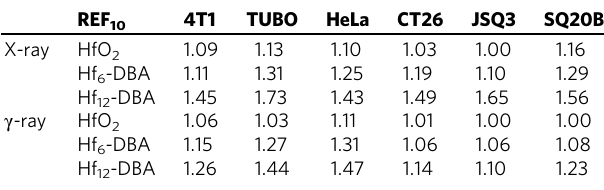
Table 1 REF 10 values by clonogenic assays in a panel of cell lines upon X-ray irradiation or γ -ray irradiation from a 60